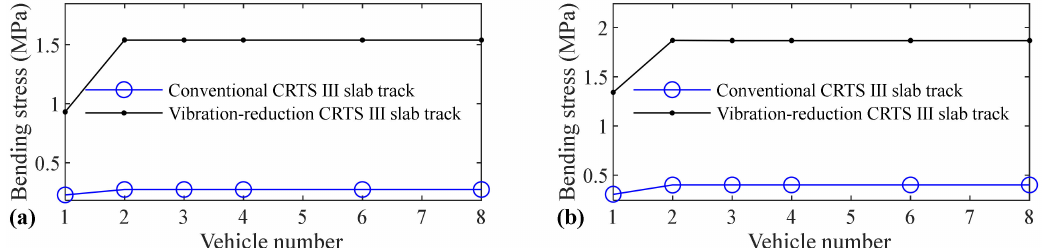
Figure 14. Relation between vehicle number and negative bending stress of slab: ( a ) without and ( b ) with random track irregularity.